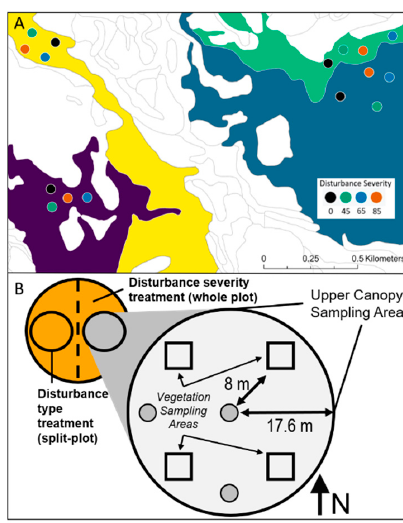
Figure 1. Disturbance treatment replicate distribution ( A ) and the split-plot experimental design ( B ) of the Forest Resilience Threshold Experiment (FoRTE) [30]. Treatment replicates serving as experimental blocks are distributed across four distinct forest ecosystems that are common to the region, and which are delineated above using the color scheme of Table 1. Lines distinguish between forest ecosystems varying by site productivity, soils, landform and species composition ( A ) [36]. Each replicate contains whole plots that were randomly assigned disturbance severities of 0, 45, 65 or 85% gross leaf area index loss and then split by top-down or bottom-up disturbance type ( B